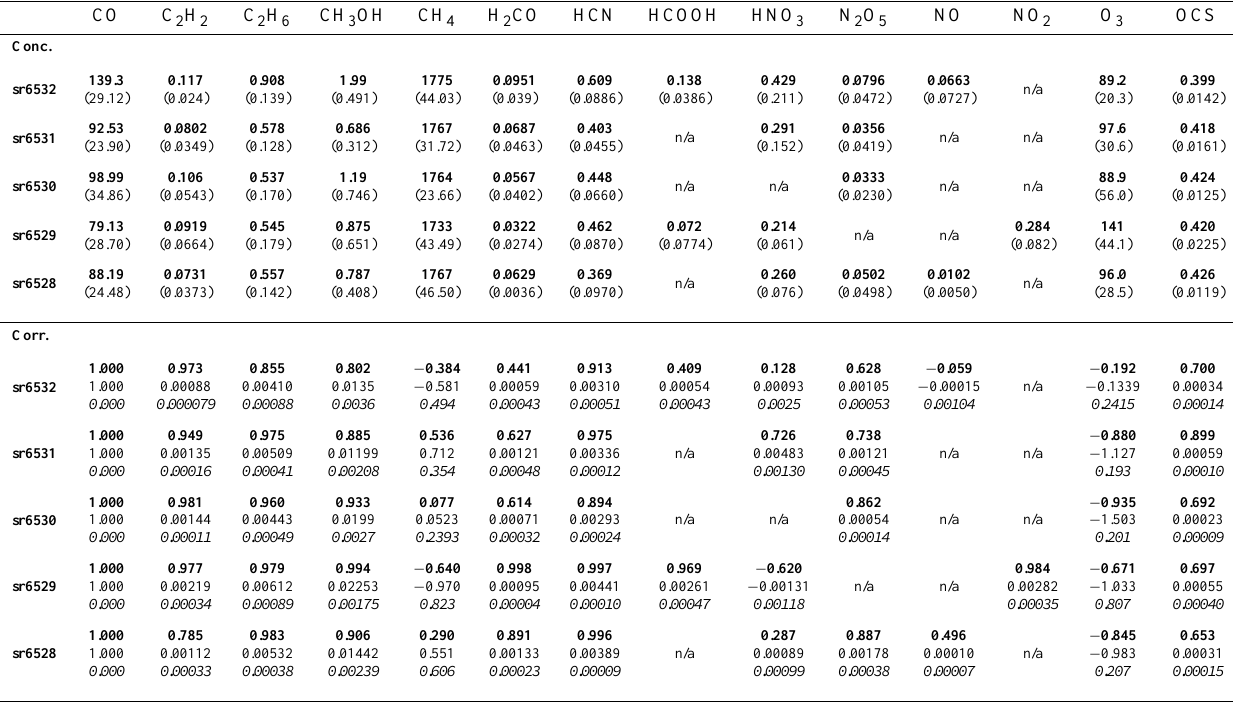
Table 3. Tabulated mean concentrations (in ppb) and Tracer-CO correlations for selected trace species from the 5 sequential measurements of the Amazon plume depicted in Fig. 4. The associated standard deviation from the mean concentrations are given in parenthesis. For the correlations, n ≈ 8 for each individual occultation, the enhancement factors with respect to CO are listed under their calculated R values along with the standard deviation (in